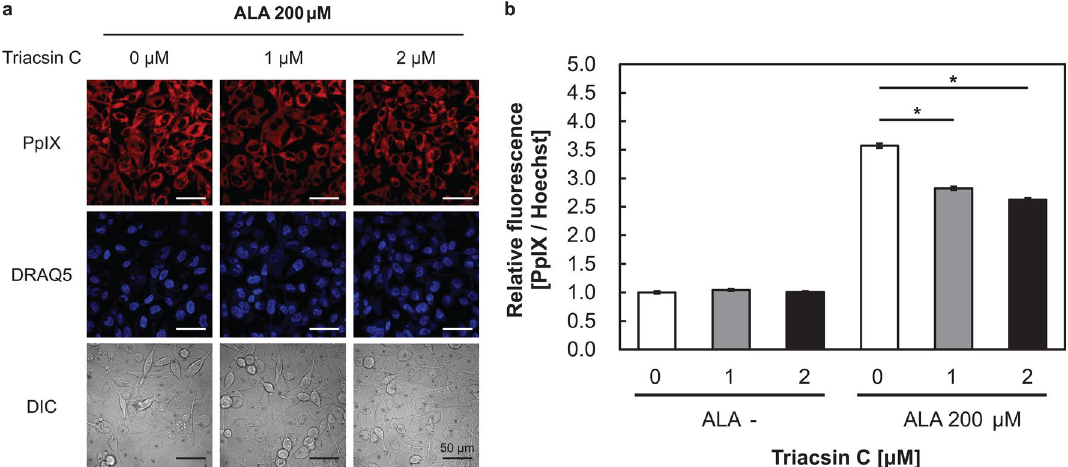
Figure 5. Triacsin C suppressed protoporphyrin IX (PpIX) accumulation after 5-aminolevulinic acid (ALA) treatment. Cells were treated with triacsin C alone for 48 h and then co-cultured with triacsin C and ALA for 24 h. ( a ) Confocal laser-scanning microscopy images of DRAQ5 (nuclei) and PpIX. Scale bar, 50 μm. ( b ) PpIX accumulation in the presence of absence of triacsin C as measured using a microplate reader. n = 3. * p < 0.001. All bars represent the SE.